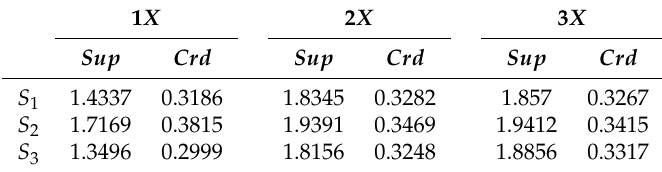
Table 8. The support degree Sup and credibility degree Crd of the sensors under different features.